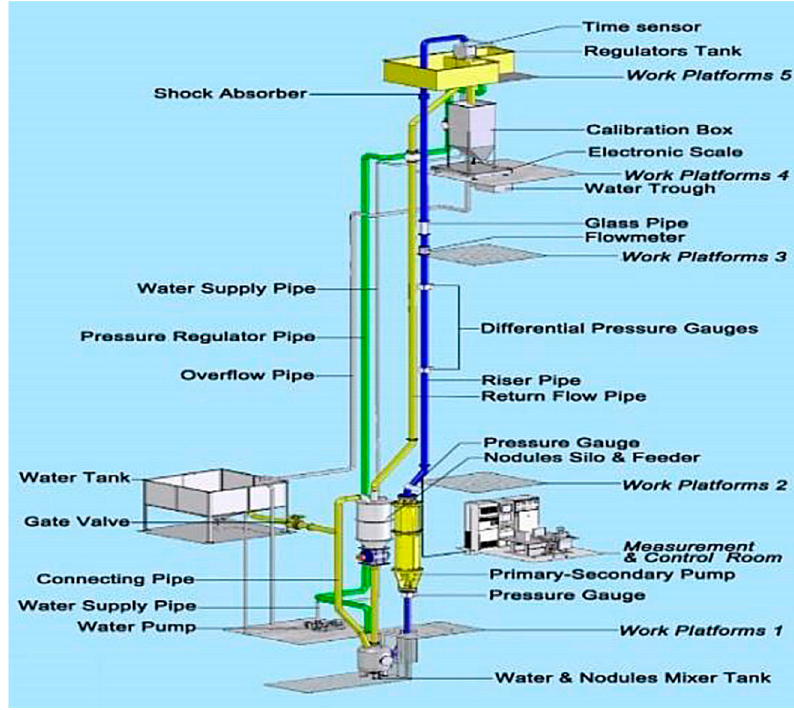
Figure 23. Schematic of the mining pump testing system.